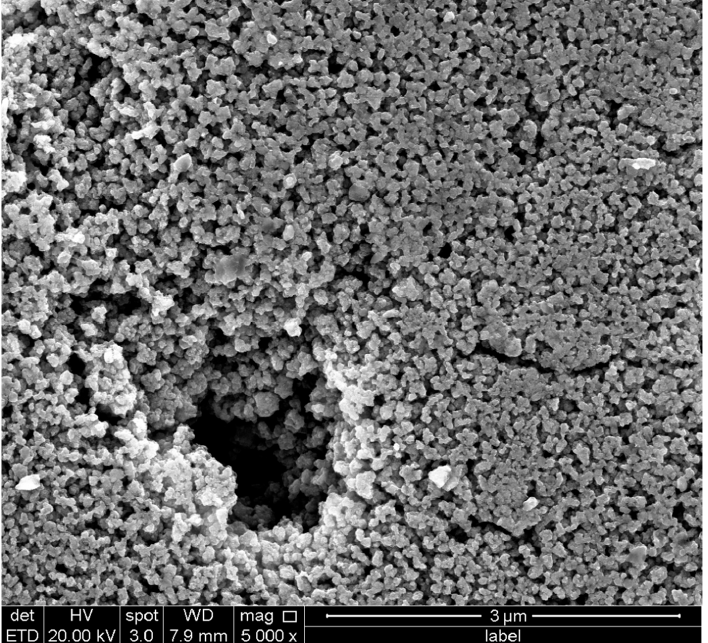
Figure 5. The SEM image of the synthesized SEM ((Model QUANTA FEG 450, FEI, Thermo Fisher Scientific, Darmstadt, Germany).